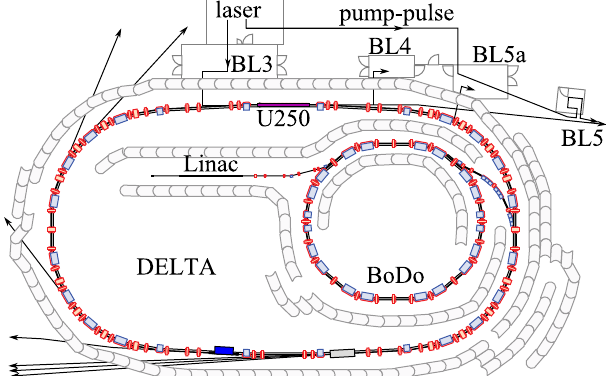
FIG. 6. Layout of DELTA and the short-pulse facility comprising a linear accelerator ( “ Linac ” ), a booster synchrotron ( “ BoDo ” ), the electron storage ring, the laser laboratory, the seeding beamline BL3, the electromagnetic undulator U250, the diagnostics beamline BL4, the THz beamline BL5a, the VUV beamline BL5, and the pump-pulse beamline (see text for details).